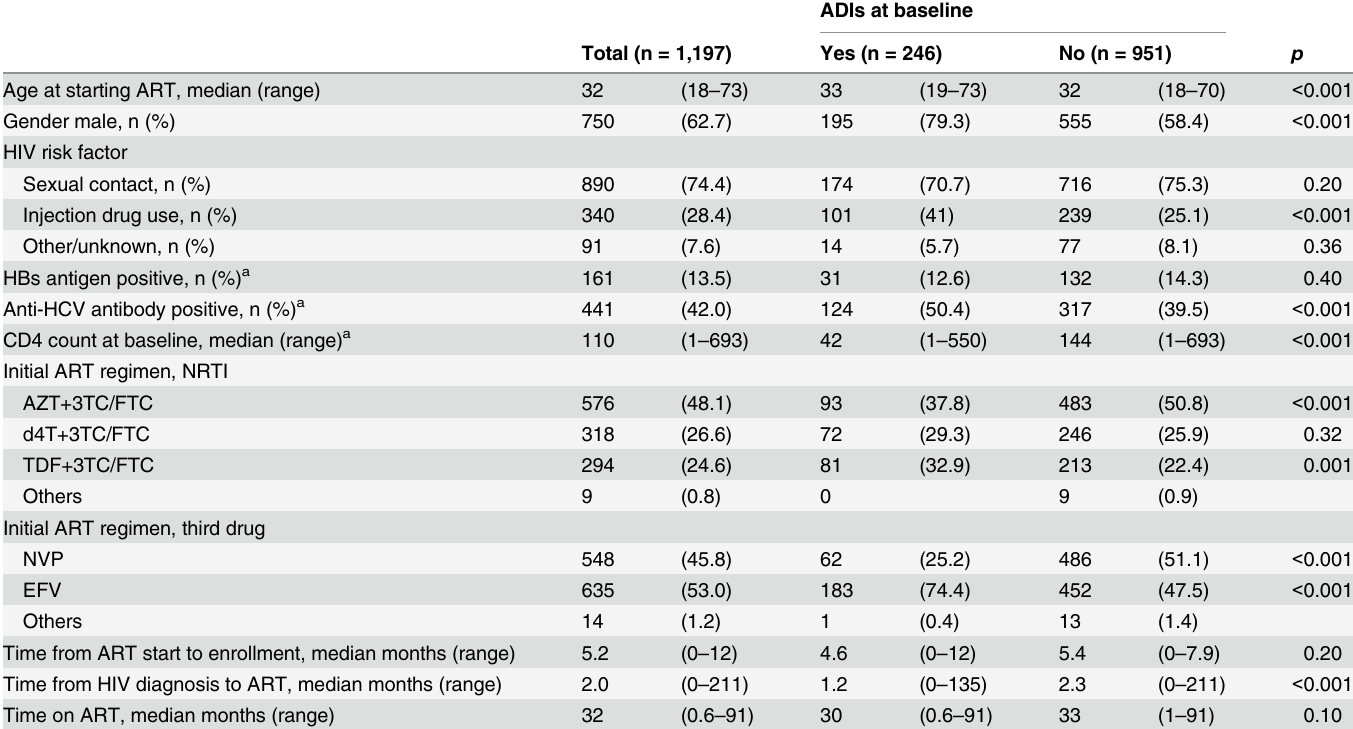
Table 1. Characteristics of Study